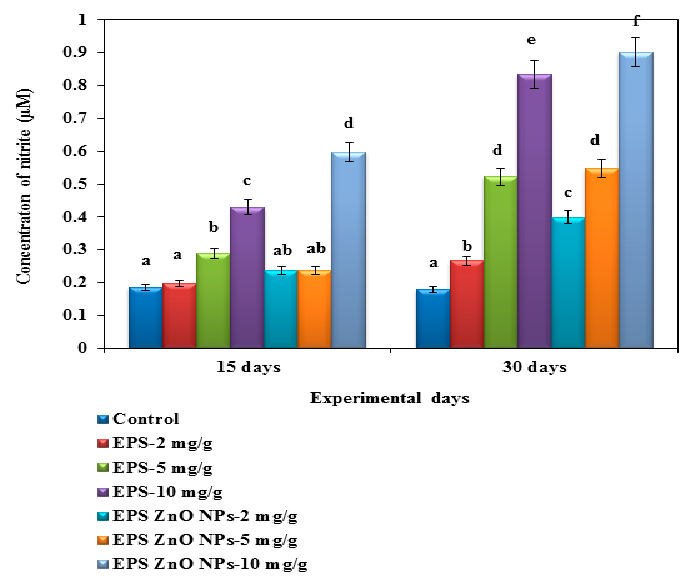
Figure 3. Reactive nitrogen species of O. mossambicus fed with EPS and EPS-ZnO NPs. T-bars indicate three replicates of mean ± SD, and different letters correspond to the statistical difference between treated groups.